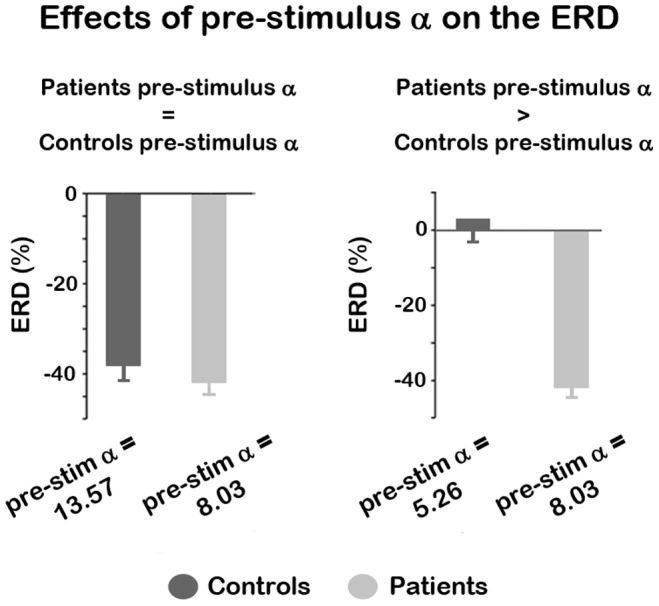
Different levels of background alpha lead to ERD modulations across groups.The left graph shows that when pre-stimulus alpha levels are equated across the groups, the ERD values are not significantly different from each other. The right graph shows that the ERD of controls is substantially lower than those of patients when controls have significantly lower pre-stimulus alpha.